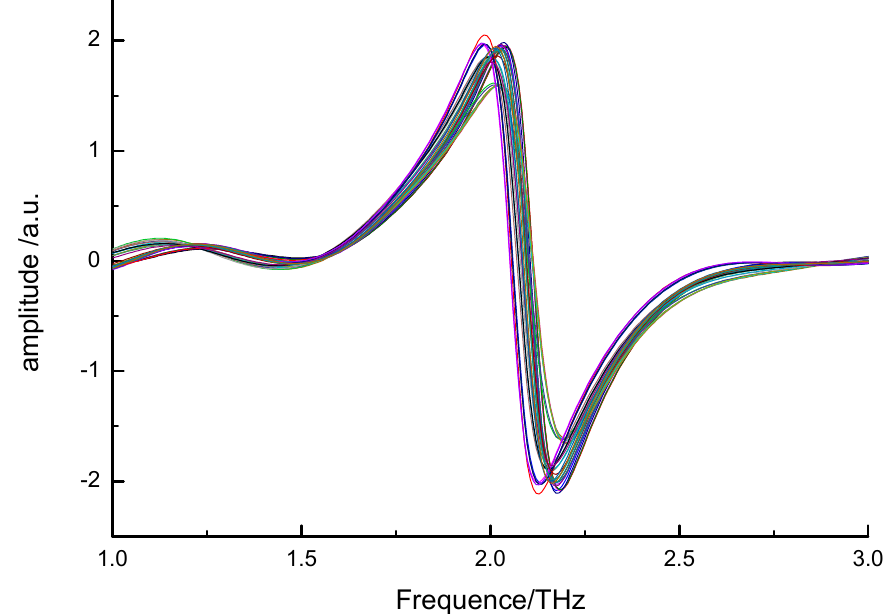
Figure 6. THz Spectra of the samples after preprocessed by SG + 1 st D. Table 1. Results of the PLS model of THz spectra by different preprocessing